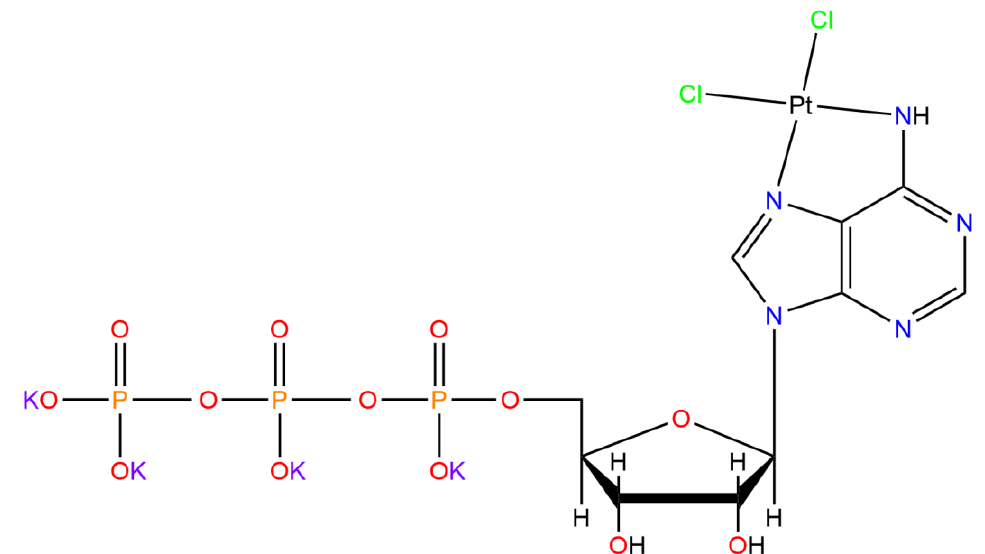
Figure 8. Chemical structure of the cis- K 4 [PtCl 2 ATP] complex, adapted from [10], published by Nature Publishing Group, 2020.